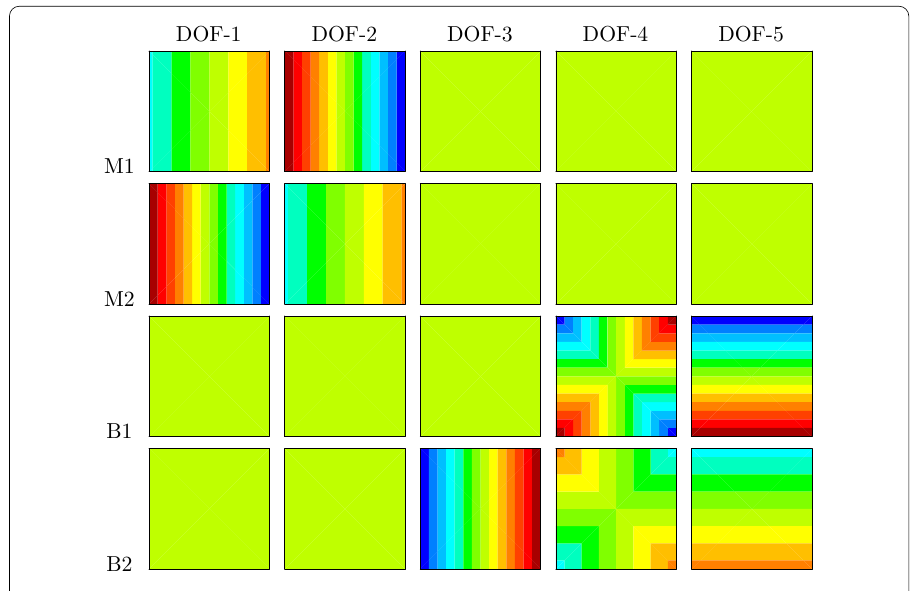
Fig. 3 Eigenmodes M1, M2, B1, B2 (red = + 1, blue = − 1, light green =